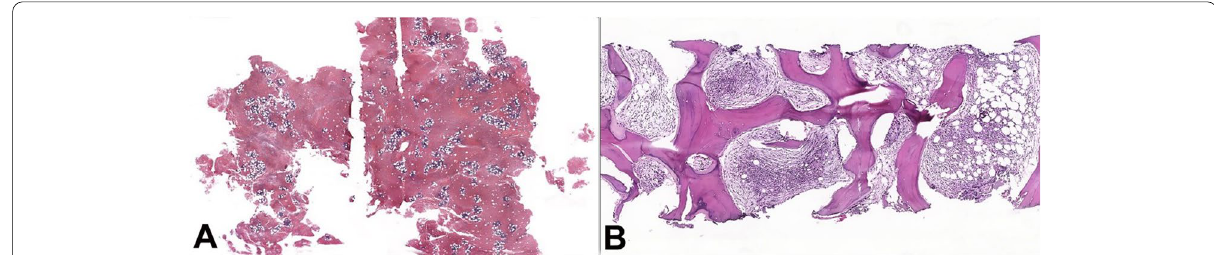
Fig. 3 A ‑ Bone marrow clot, B ‑ Bone marrow biopsy. (A and B